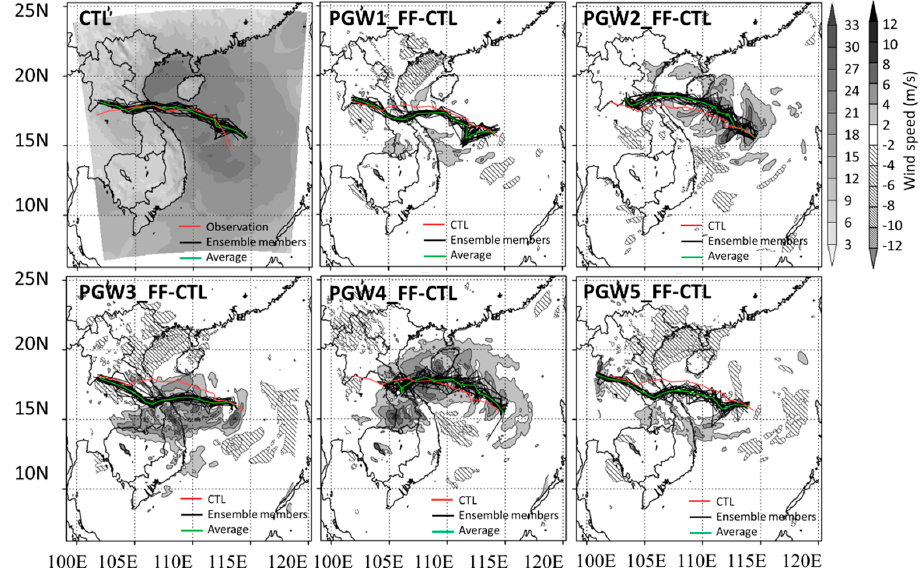
Figure 8. The average spatial distribution of MWS and the track of CTL, and different spatial distributions of average MWS between PGW_FF experiments with tracks from nineteen ensemble members of the typhoon, and the CTL run.